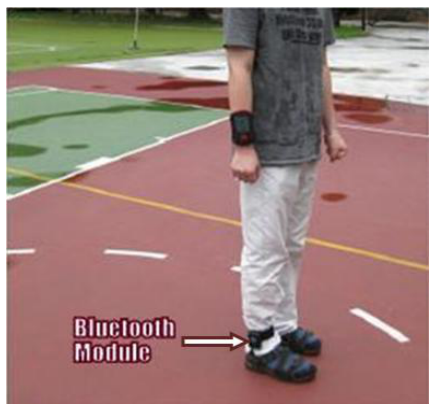
Figure 25. In-shoe plantar pressure measurement and analysis system based on fabric pressure sensing array